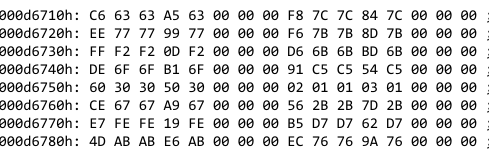
Figure 11: The the first 16 elements of T 0 and T 0